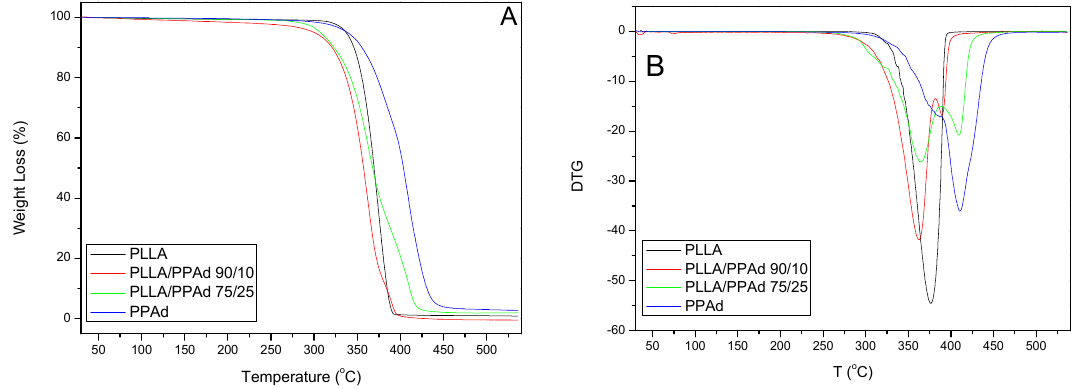
Figure 7. ( A ) Mass loss as a function of temperature with heating rate β = 10 ◦ C / min. ( B ) Di ff erential mass loss as a function of temperature, with heating rate β = 10 ◦ C / min. Table 3. Data obtained by thermogravimetric analysis of synthesized polymers.